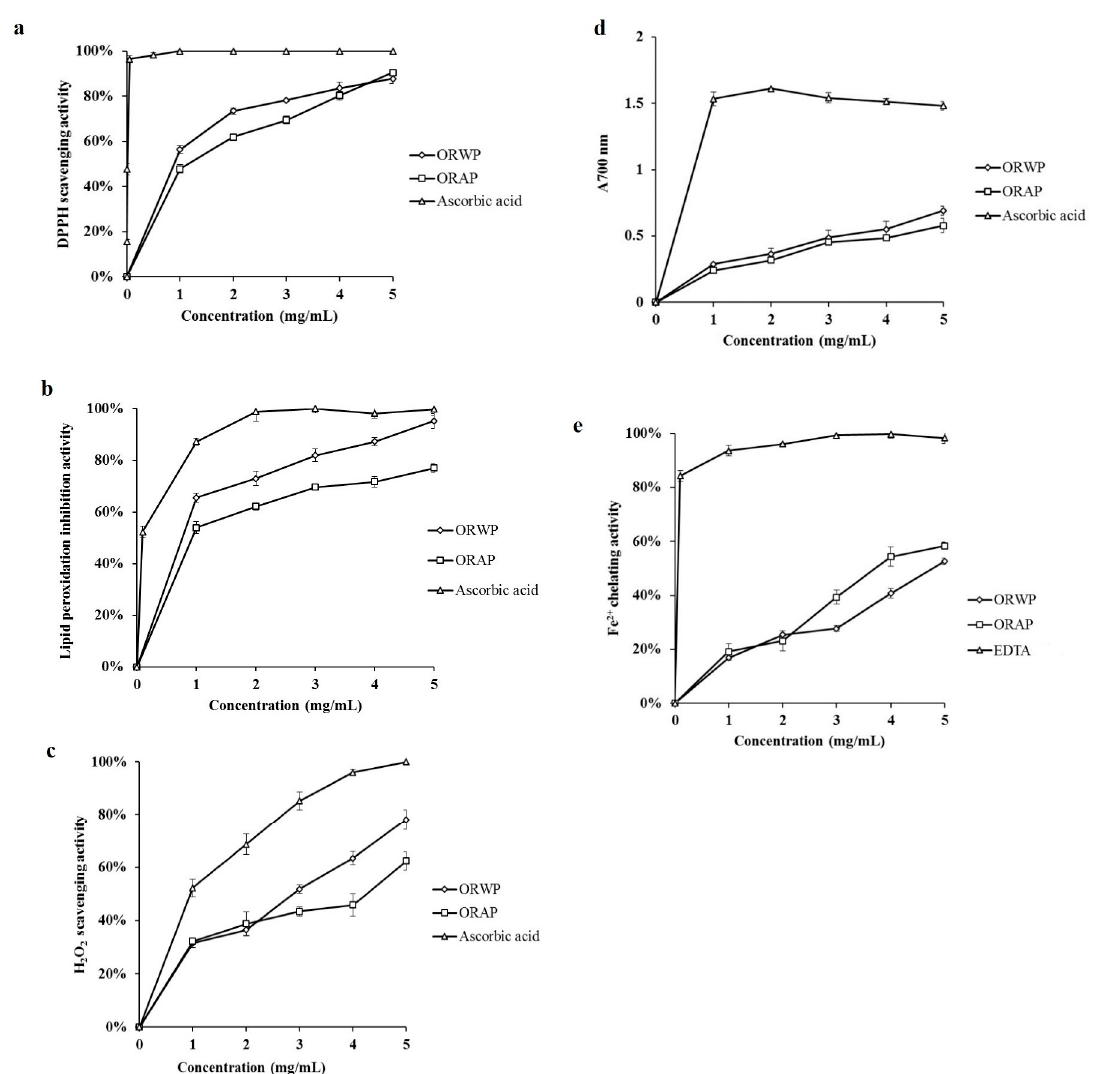
Figure 2. Antioxidant activity of ORWP and ORAP. ( a ) scavenging of DPPH radicals; ( b ) inhibitory effect on lipid peroxidation; ( c ) hydrogen peroxide scavenging activity; ( d ) reducing power; and ( e ) Fe 2+ ion chelating activity. The values are representative of three separate experiments.